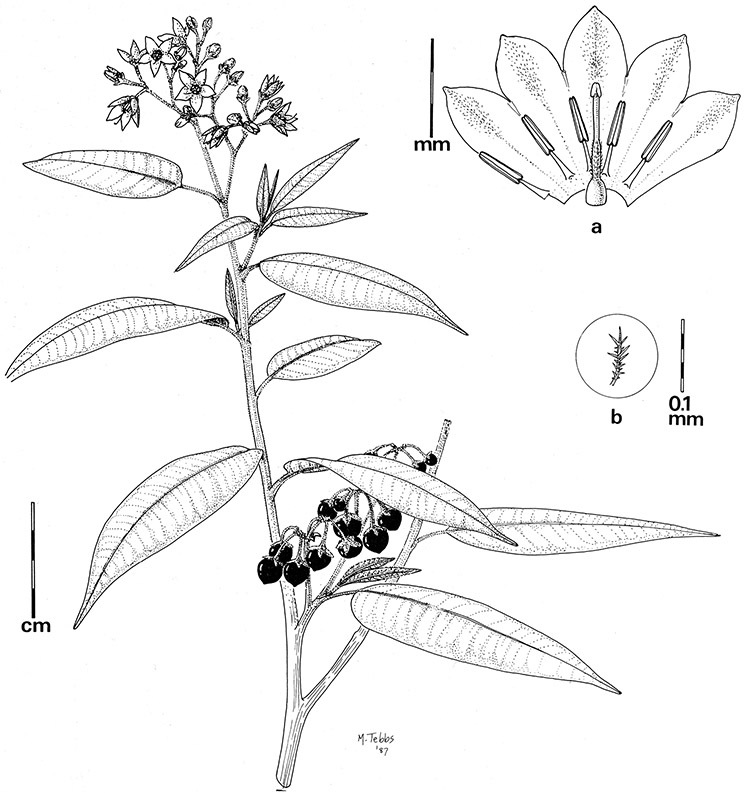
Solanum muenscheri Standl. & Steyerm. (A–B drawn from Steyermark 35633). Reproduced from Knapp (1989) with permission of the Natural History Museum Botany Library. Illustration by Margaret Tebbs.